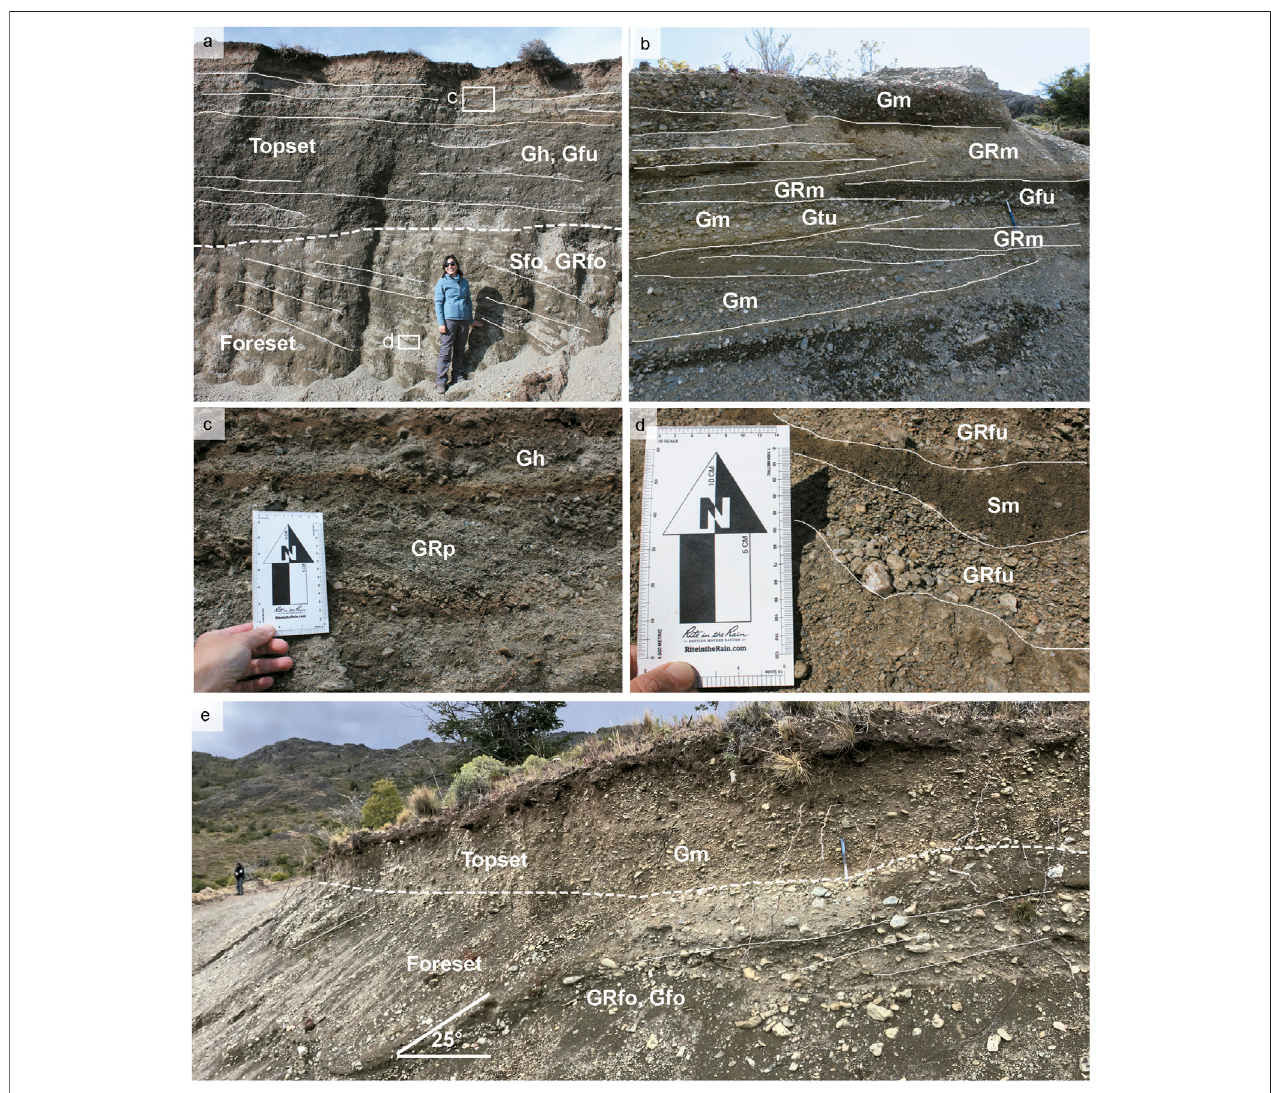
FIGURE 5 | Main stratigraphic and sedimentological features of deltas in Frutillar sector. (A) Outcrop showing the topset/foreset contact on site 2. (B) Trough cross-bedded gravel in topset. (C) Planar cross-bedding in topset. (D) Upward fi ning granules in foreset. (E) Topset/Foreset contact on site 3. Gm, clast-supported massive gravel; Gfo, deltaic foreset gravel; Gh, horizontally bedded gravel; Gt, Trough cross-bedded gravel; Gfu, Upward- fi nning gravel; GRm, massive granule; GRfu, upward- fi nning granule; GRp, Cross-bedded granule; GRfo, deltaic foreset granule; Sfo, deltaic foreset sand; Sm, massive sand.